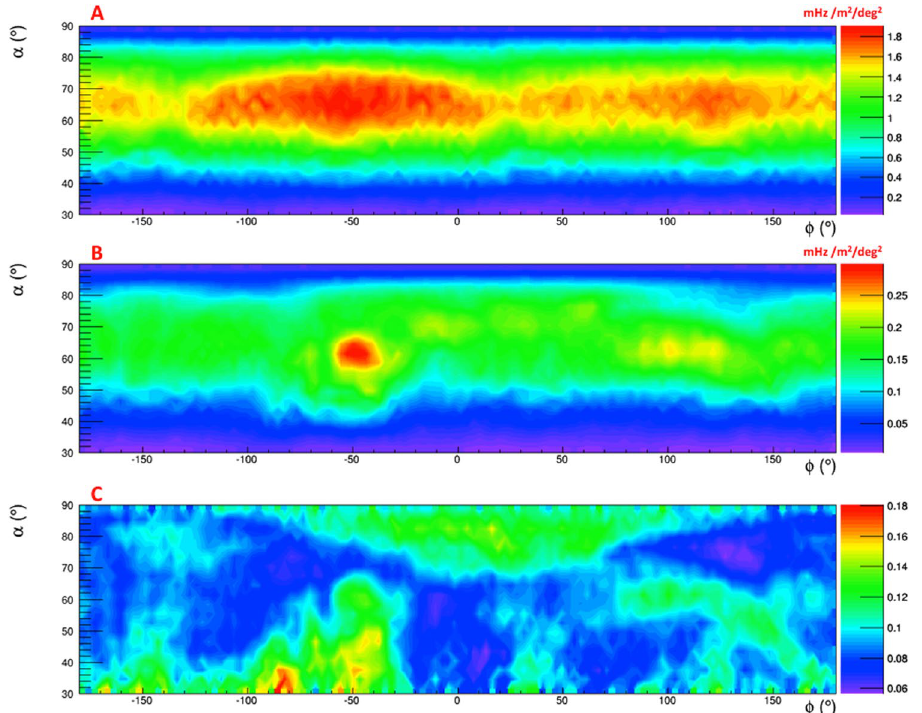
Figure 14. ( A ) Rate of free-sky muons measured in laboratory. ( B ) Rate of underground muons measured under Mt Echia. ( C ) Measured transmission. The drawing was obtained using the software root